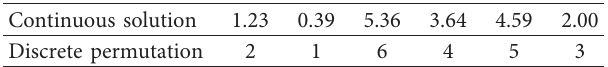
Figure 2: Some convergence curves for benchmark set Table 10: Mapping between continuous solutions and discrete permutations using ROVs.